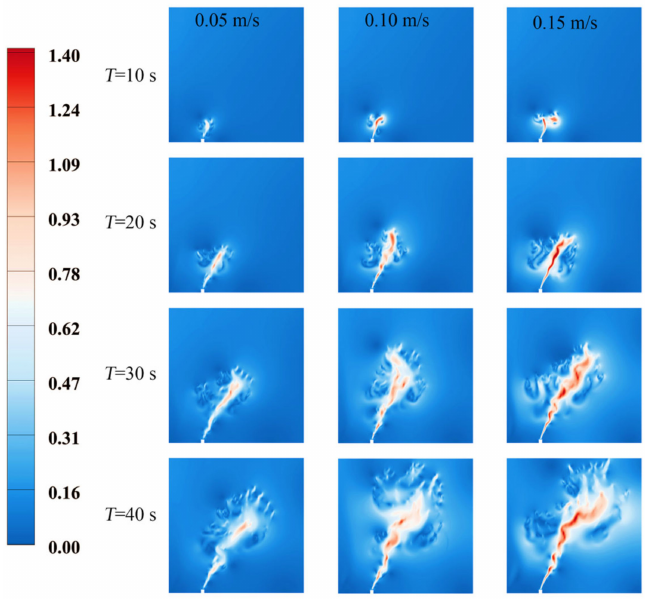
Figure 6. Influence of ocean current velocity on oil spill leakage and diffusion ( U P = 0.15 m/s).